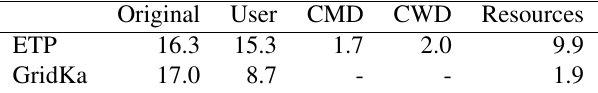
Table 1. Average similarities of jobs within a cluster per clustering method and dataset. Similarity is the di ff erence of the minimum and maximum resource usage of jobs in each workflow. Lower number means higher